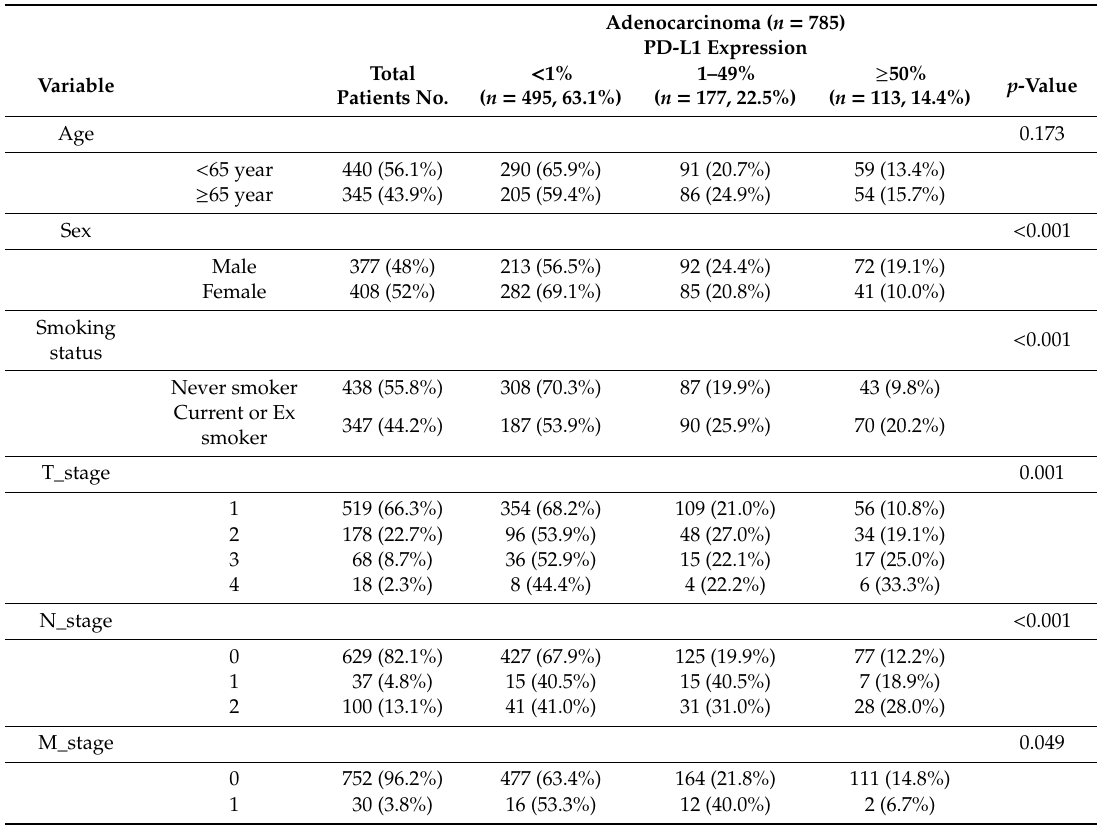
Table 1. Association between programmed cell death ligand 1 (PD-L1) expression status and clinicopathological features in 785 lung